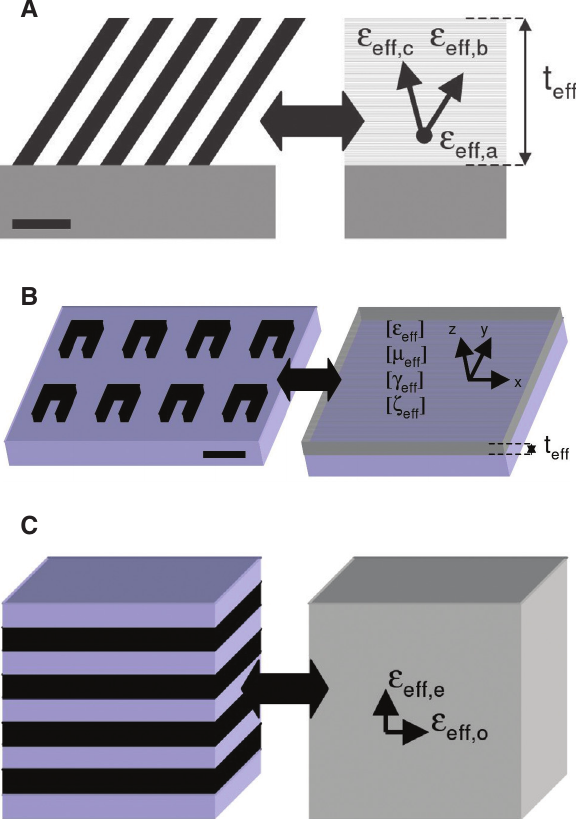
Figure 8 More metamaterials – biaxial anisotropy, optical magnet- ism, and hyperbolic material. Schematic representation of (A) a thin film consisting of slanted nanocolumns; (B) a 2D assembly of supported U-shaped resonators; (C) a multilayered hyperbolic meta- material. Their effective counterparts are also depicted, together with the parameters that can be determined from measurements. In (A), these parameters are the orientation of the principal axes of the dielectric tensor, its diagonal components, the film effective thick- ness. In (B), the effective thickness and the four constitutive tensors (dielectric permittivity [ ε ], magnetic permeability [ μ ], chirality eff eff [ γ ], and [ ζ ]). In (C), the effective ordinary ε and extraordinary eff eff eff,o ε dielectric functions. Typical order-of-magnitude scale bars are eff,e also shown: 50 nm for (A), 200 nm for (B). In (B), the principal axes in which the constitutive tensors are expressed are shown. In (C), the multilayer period must be small compared to the wavelength